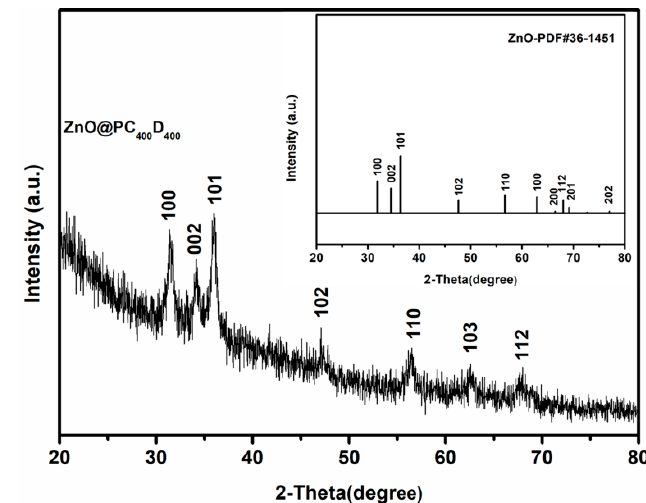
Figure 1. ( a ) TEM image and (inset) size distribution of ZnO@PC 400 D 400 NPs; ( b ) TEM image and (inset) HRTEM of ZnO@PC 400 D 400 NPs.